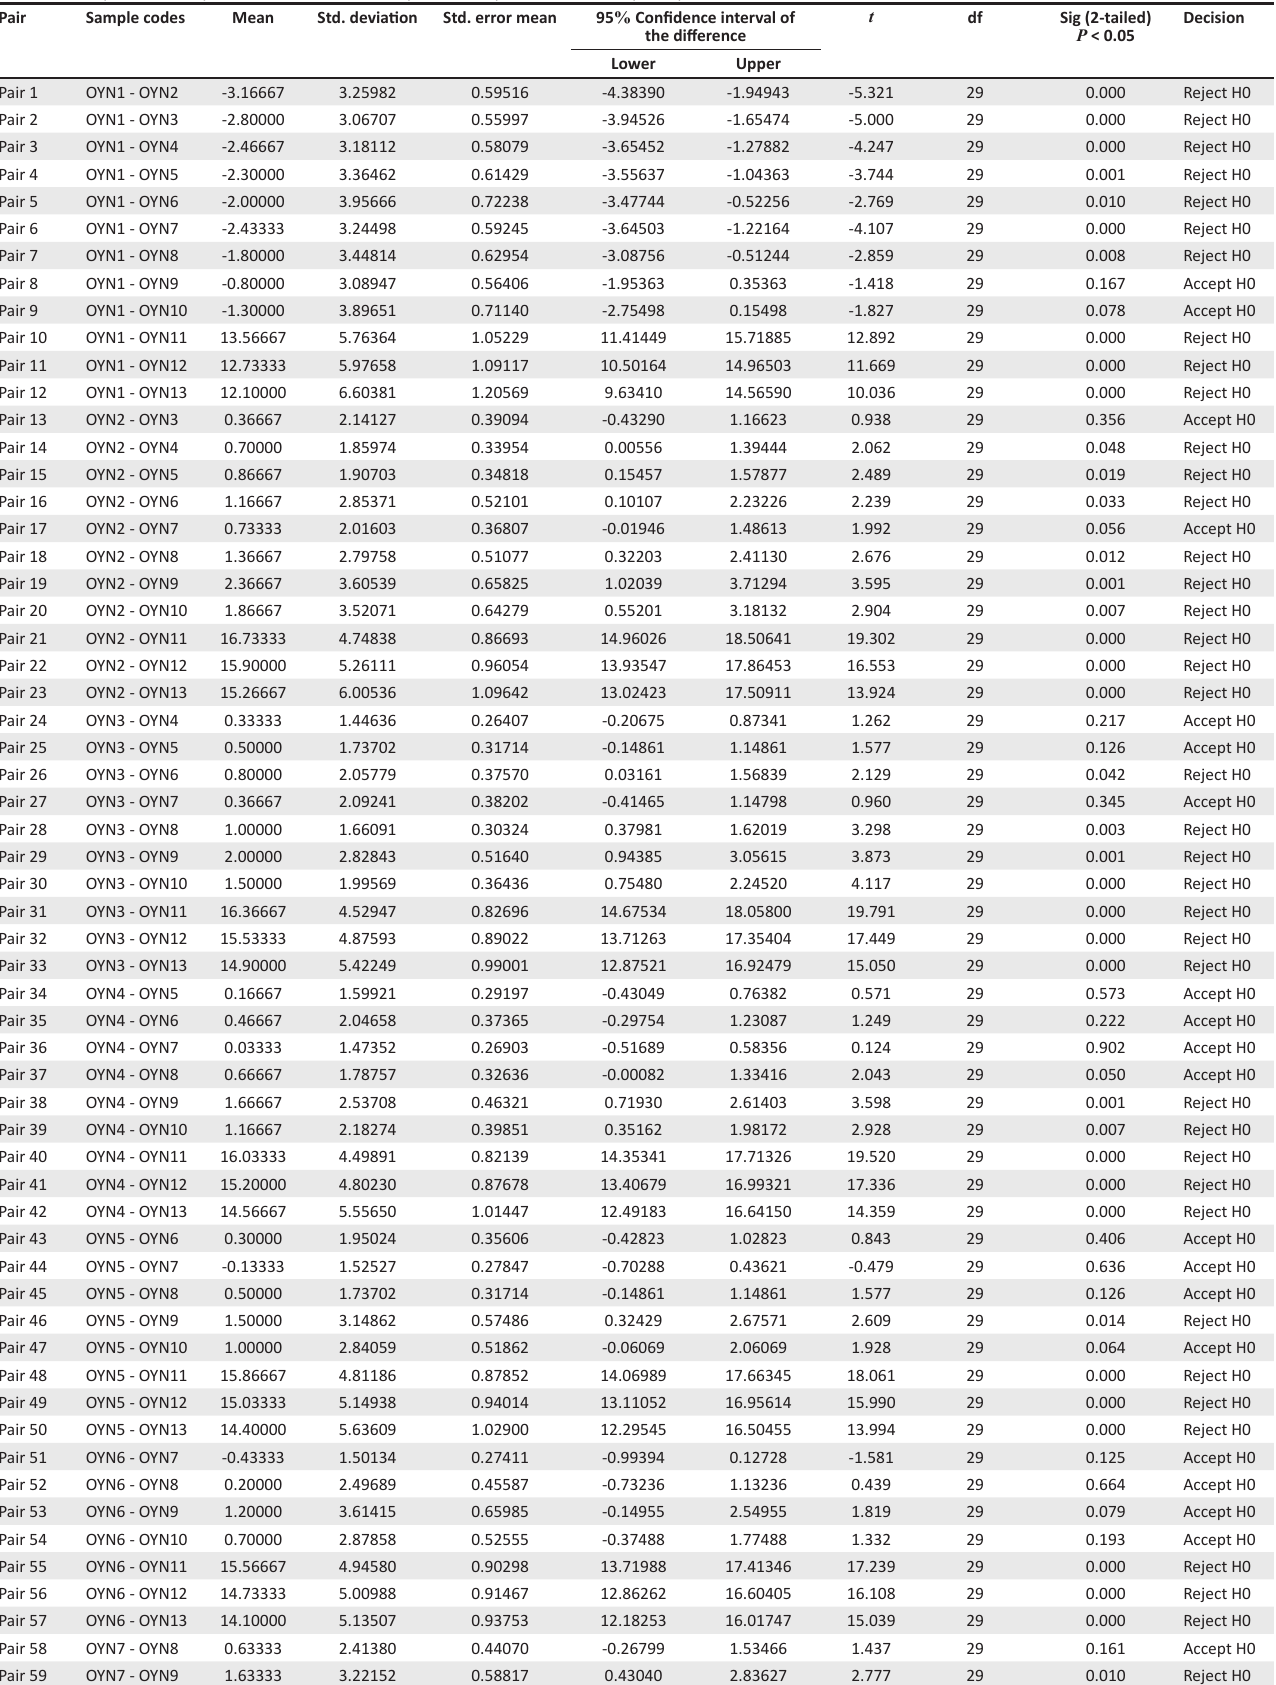
TABLE 1: Comparative analysis of the inhibition zones produced by the different soap samples. Pair Sample